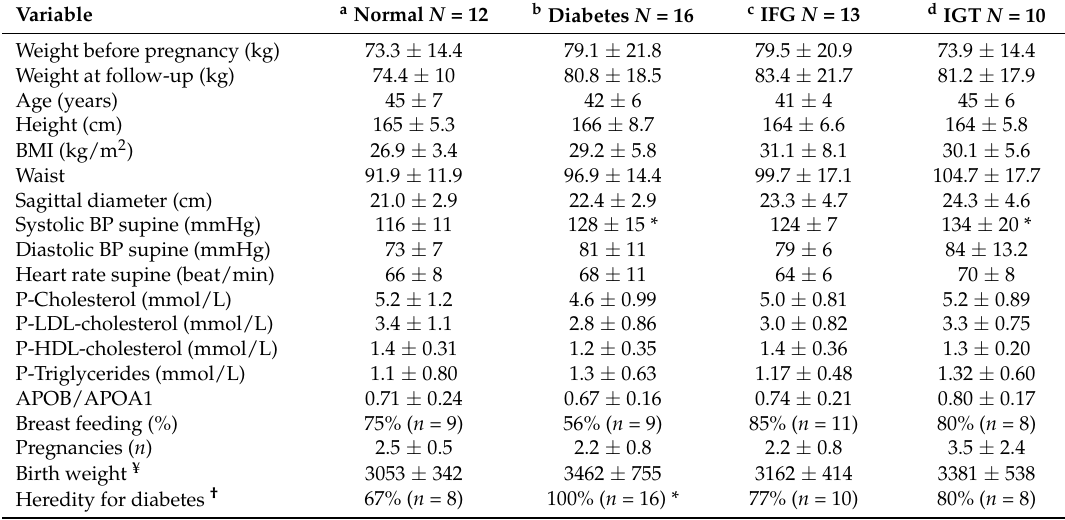
Table 1. Anthropometric data and laboratory tests for 51 women followed up after gestational diabetes mellitus (GDM), divided into groups of a normal glucose tolerance N = 12, b diabetes mellitus N =